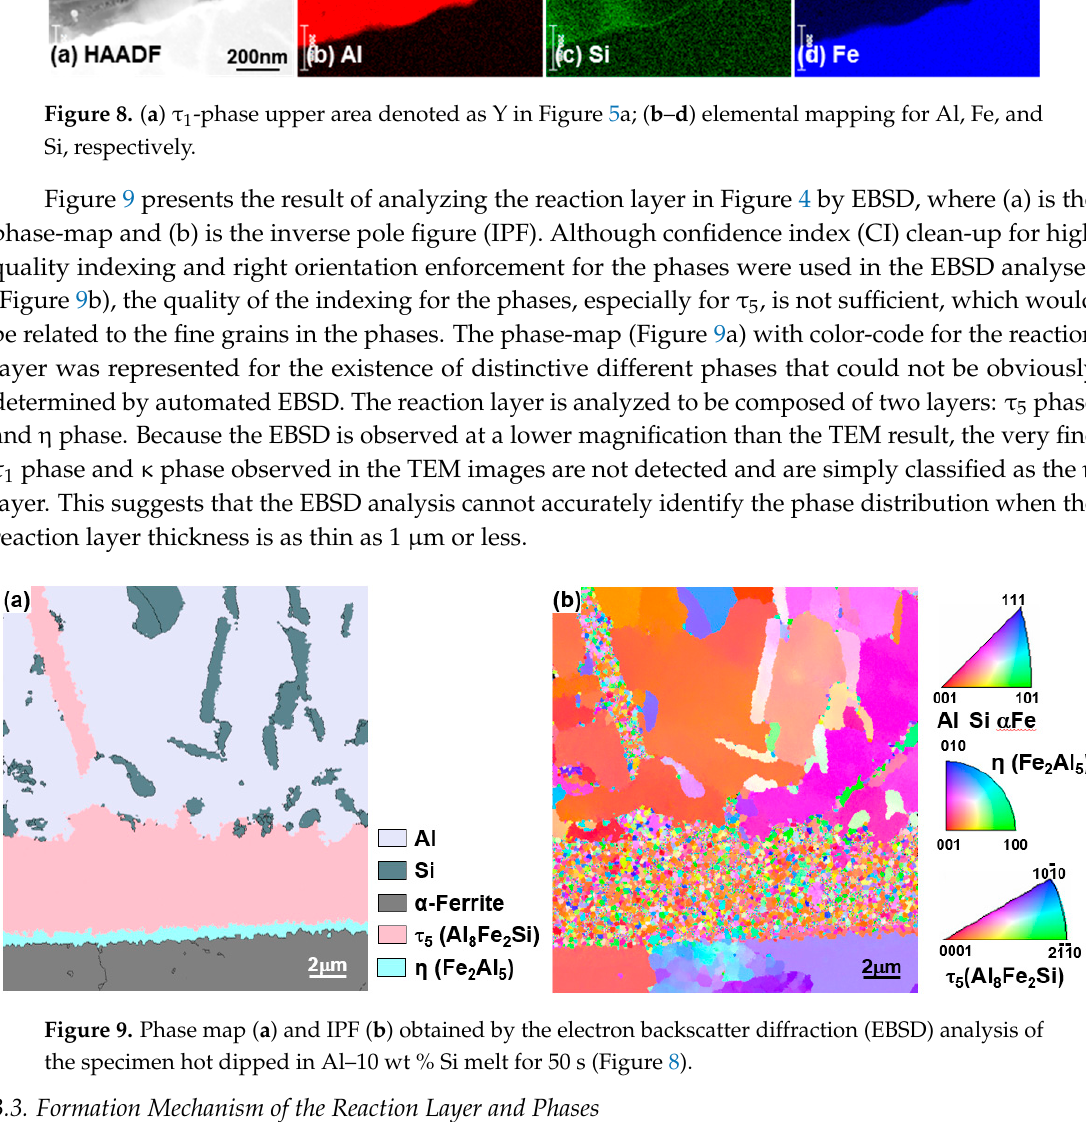
Figure 9. Phase map ( a ) and IPF ( b ) obtained by the electron backscatter diffraction (EBSD) analysis of the specimen hot dipped in Al–10 wt % Si melt for 50 s (Figure 8).